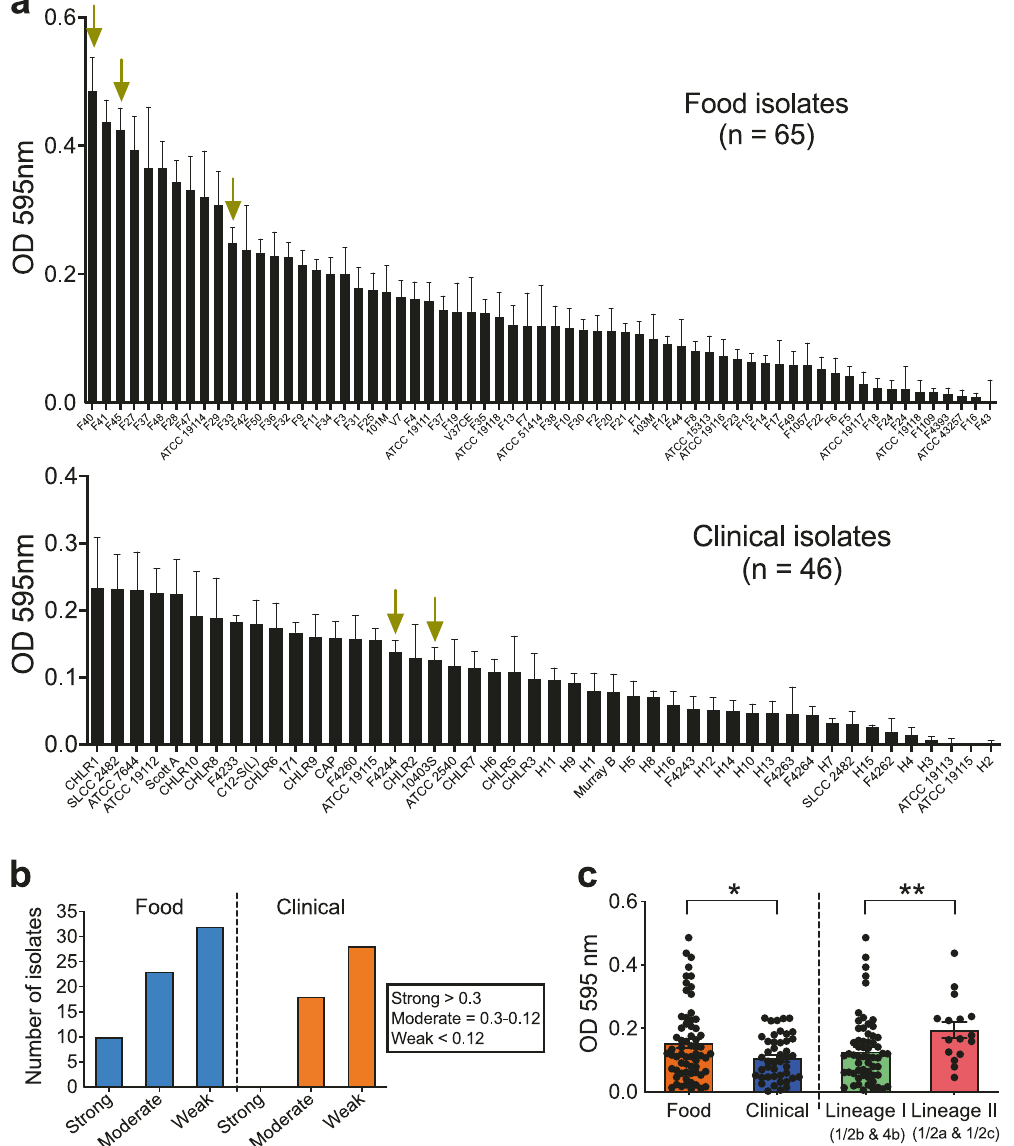
Fig. 1 Quanti fi cation of L. monocytogenes bio fi lm formation and morphological analysis. a The bio fi lm-forming capabilities of over 100 food-(top panel) or clinical-isolated (bottom panel) L. monocytogenes ( Lm ) strains were tested using crystal violet staining assay. Arrows indicate the strains selected for further characterization. b Assemblage (strong, moderate, and weak) of isolates based on their ability to form bio fi lms. c Comparison of bio fi lm formation by food and clinical isolates and isolates of lineage I and II. Food isolates have signi fi cantly higher bio fi lm-forming capability than the clinical isolates, and isolates of lineage II also have a signi fi cantly higher capacity than isolates of lineage I. Mann – Whitney test was used for statistical analysis. ** P < 0.005; * P <